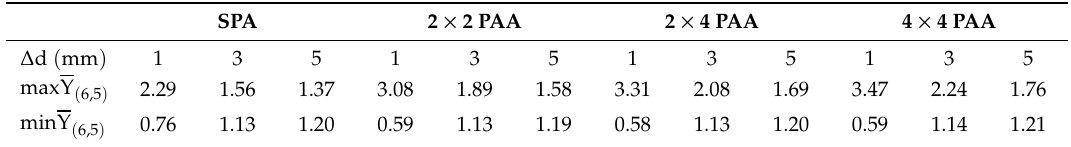
( f ) Figure 8. TPD distribution for the SPA equivalent source without (top line, scenario 5) and with PEC (middle line, scenario 6) and for the SPA (bottom line, scenario 7) normalized to its maximum at: ( a ) d = 4.75 mm; ( b ) d = 6.5 mm; ( c ) d = 7.25 mm; ( d ) d = 9.0 mm; ( e ) d = 17.25 mm; ( f ) d =18.75 mm. The sets d = (4.75; 7.25; 17.25) mm and d = (6.5; 9.0; 18.75) mm correspond to the TPD maxima and minima, respectively. The cross-section distributions along x -axis at y = 0 mm of the x component of 𝐄 (cid:2888)(cid:2919)(cid:2928)(cid:2915)(cid:2913)(cid:2930) , 𝐄 (cid:2904)(cid:2925)(cid:2930)(cid:2911)(cid:2922) , and 𝐄 (cid:2902) are plotted in Figure 9. The amplitude of 𝐄 (cid:2904)(cid:2925)(cid:2930)(cid:2911)(cid:2922) is directly related to the phase difference between 𝐄 (cid:2888)(cid:2919)(cid:2928)(cid:2915)(cid:2913)(cid:2930) and 𝐄 (cid:2902) . For d = 7.25 mm, 𝐄 (cid:2888)(cid:2919)(cid:2928)(cid:2915)(cid:2913)(cid:2930) is in phase with 𝐄 (cid:2902) around x = 0 mm. This null